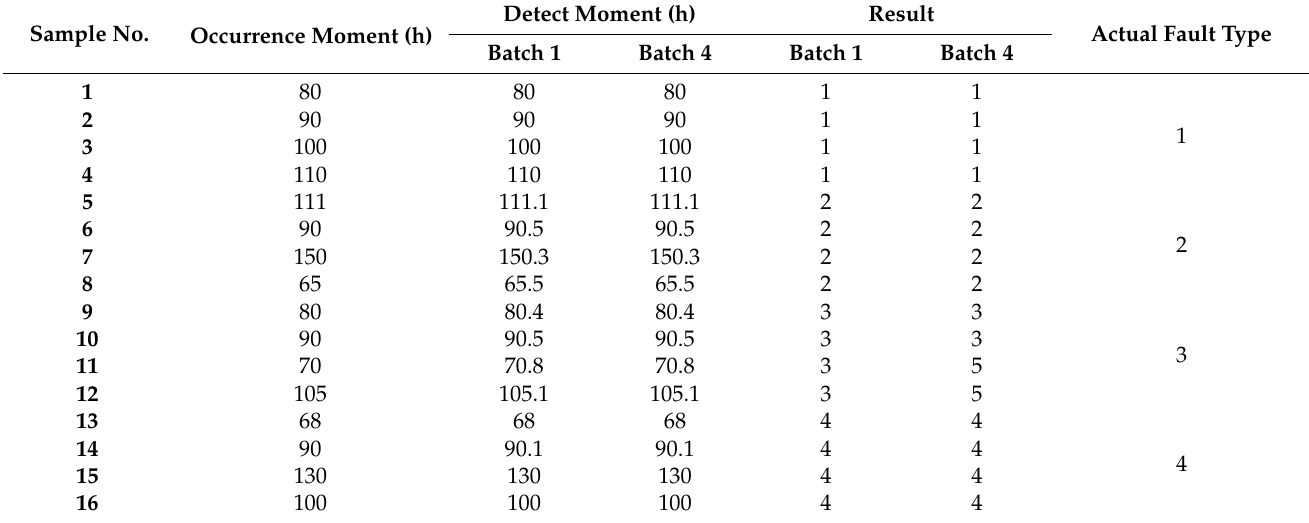
Table 4. The fault diagnosis result of LAS-QTA